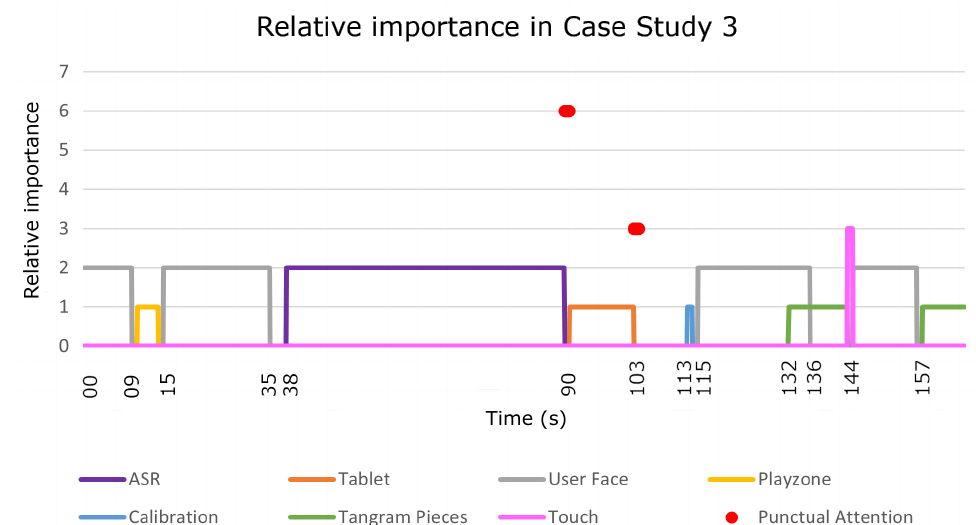
Figure 11. The relative importance of the detectors during sustained and punctual attention in case study 3. The lines show the sustained attention of the different detectors that were used during the case study. The red dots show the punctual attention that was detected. The first dot was produced by the user’s response via ASR and the second dot was produced by the user’s response via the